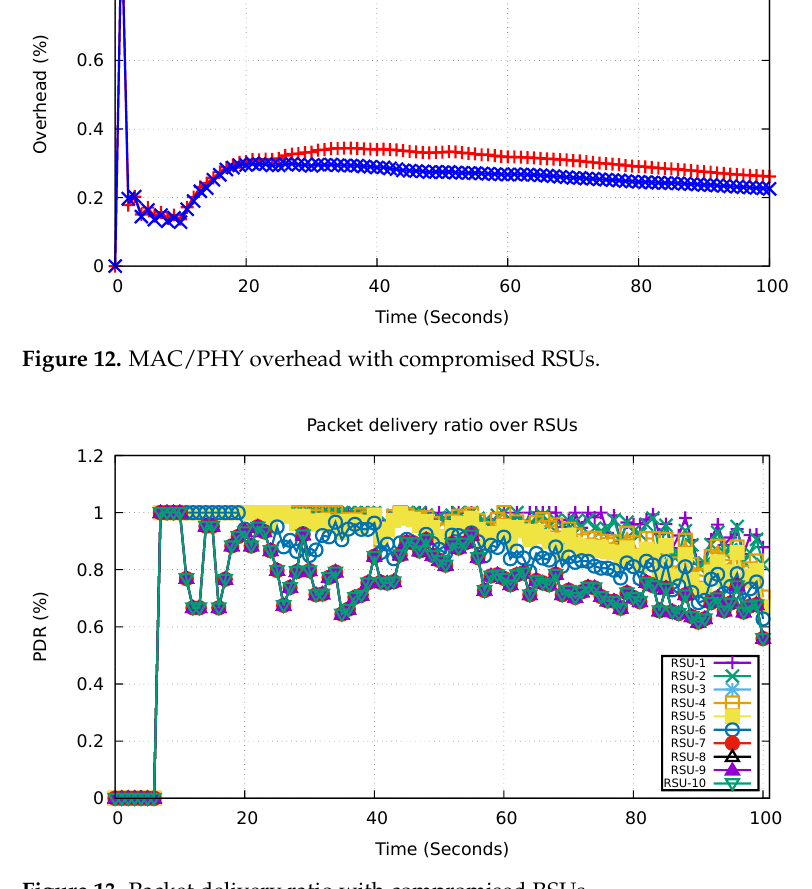
Figure 13. Packet delivery ratio with compromised RSUs. Table 3. Simulation